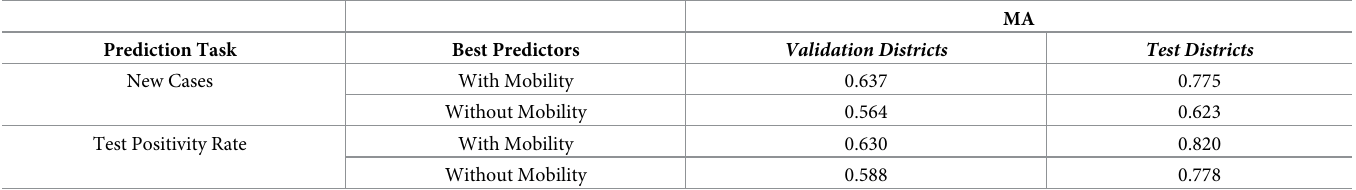
Table 4. Performance of our best performing predictions as classified into tiers. The performance of our categorization scheme on new cases and the test positivity rate is reported as magnitude accuracy (MA).